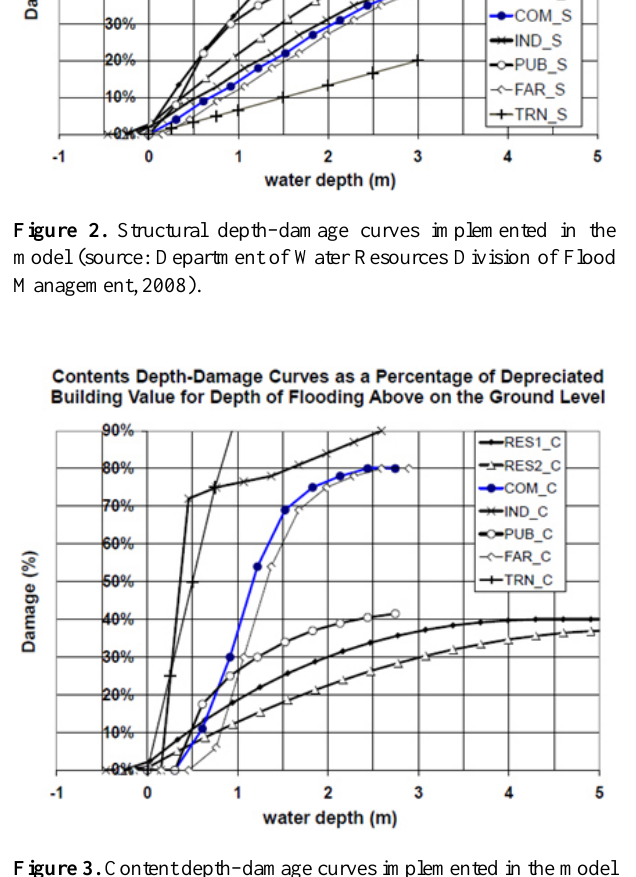
Figure 3. Content depth–damage curves implemented in the model (source: Department of Water Resources Division of Flood Man- agement, 2008).